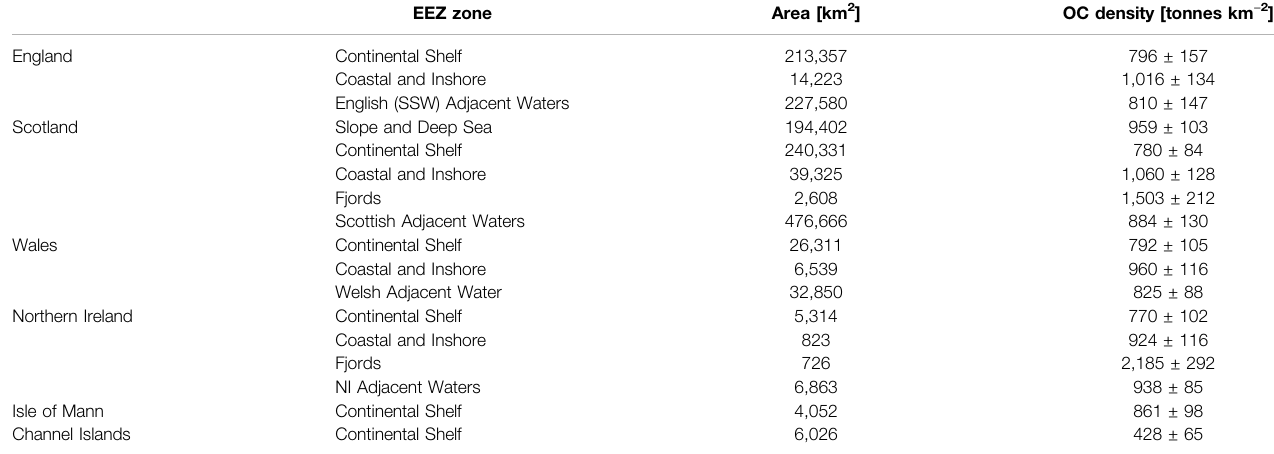
TABLE 3 | OC stock (Mt) and density (tonnes km − 2 ) for the seabed monitored and managed by the different administrations, highlighting the hotspots for